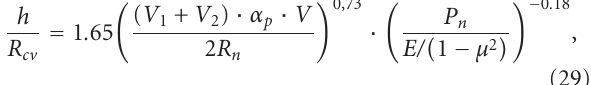
piezocoe ffi cient; R n —reduced radius of